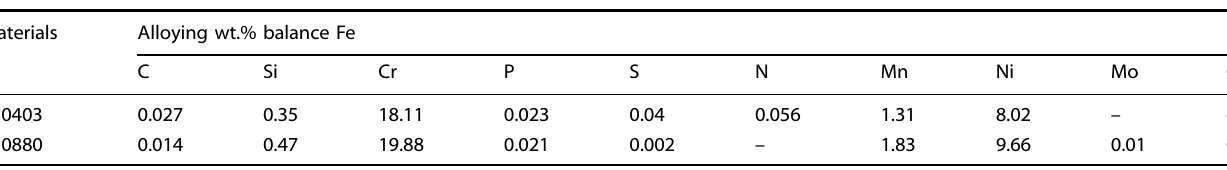
Fig. 9 Schmid factor shear stress and Taylor factor shear stress of the grain pairs within subgroups a – c as identi fi ed on mismatch map Fig. 8. Table 1. Alloy and weld metal composition